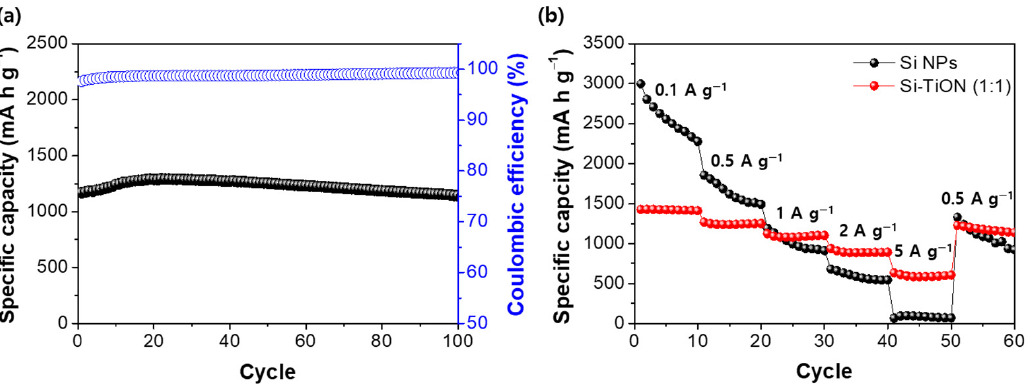
Figure 6. ( a ) Cycling performance of Si-TiON (1:1) measured at 1 A g − 1 and ( b ) comparison of rate performances of Si NPs and Si-TiON (1:1) at different current densities.